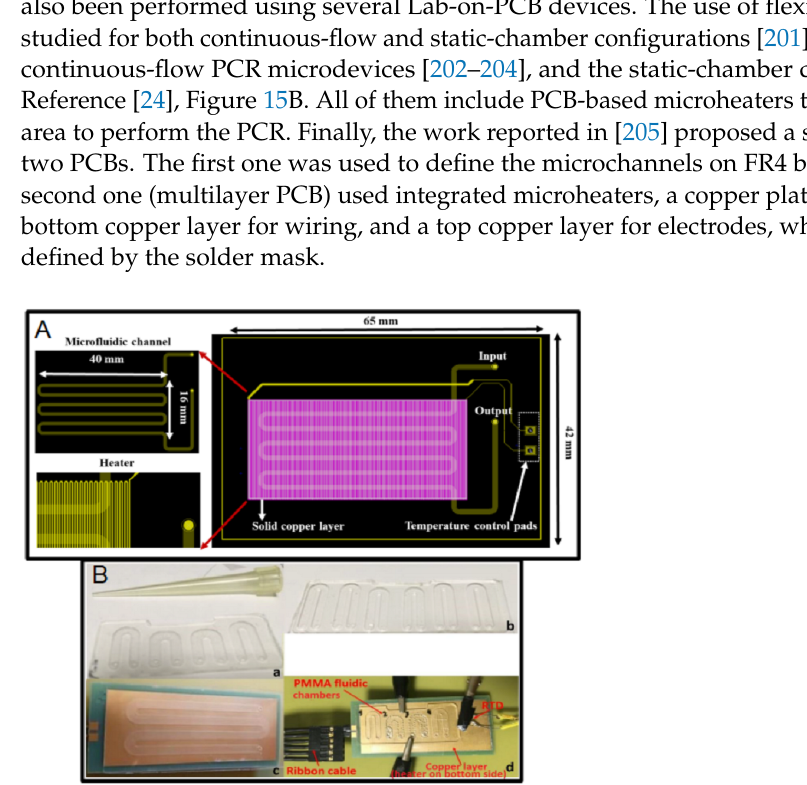
circular gold-plated electrodes and two cylindrical electrodes, used as the fluidic inlet and outlet using